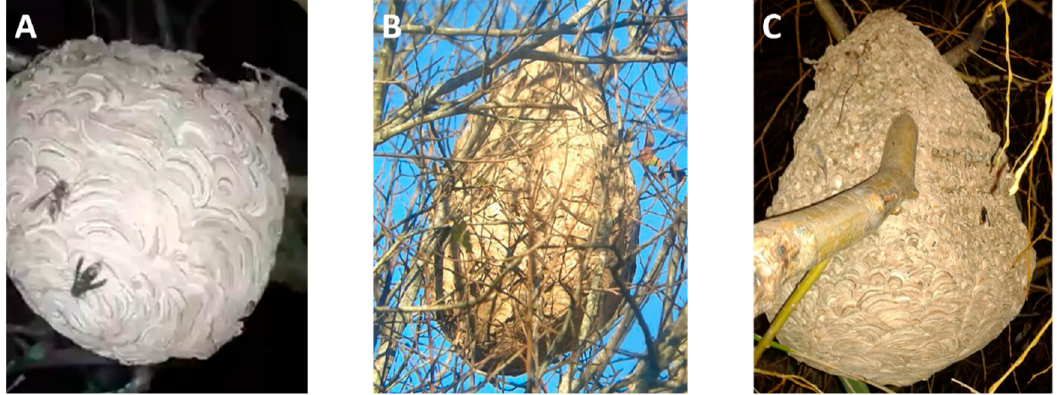
Figure 2. The Vespa velutina nests identified as ( A – C ) prior to their removal on 2, 5, and 11 January of 2019, respectively.